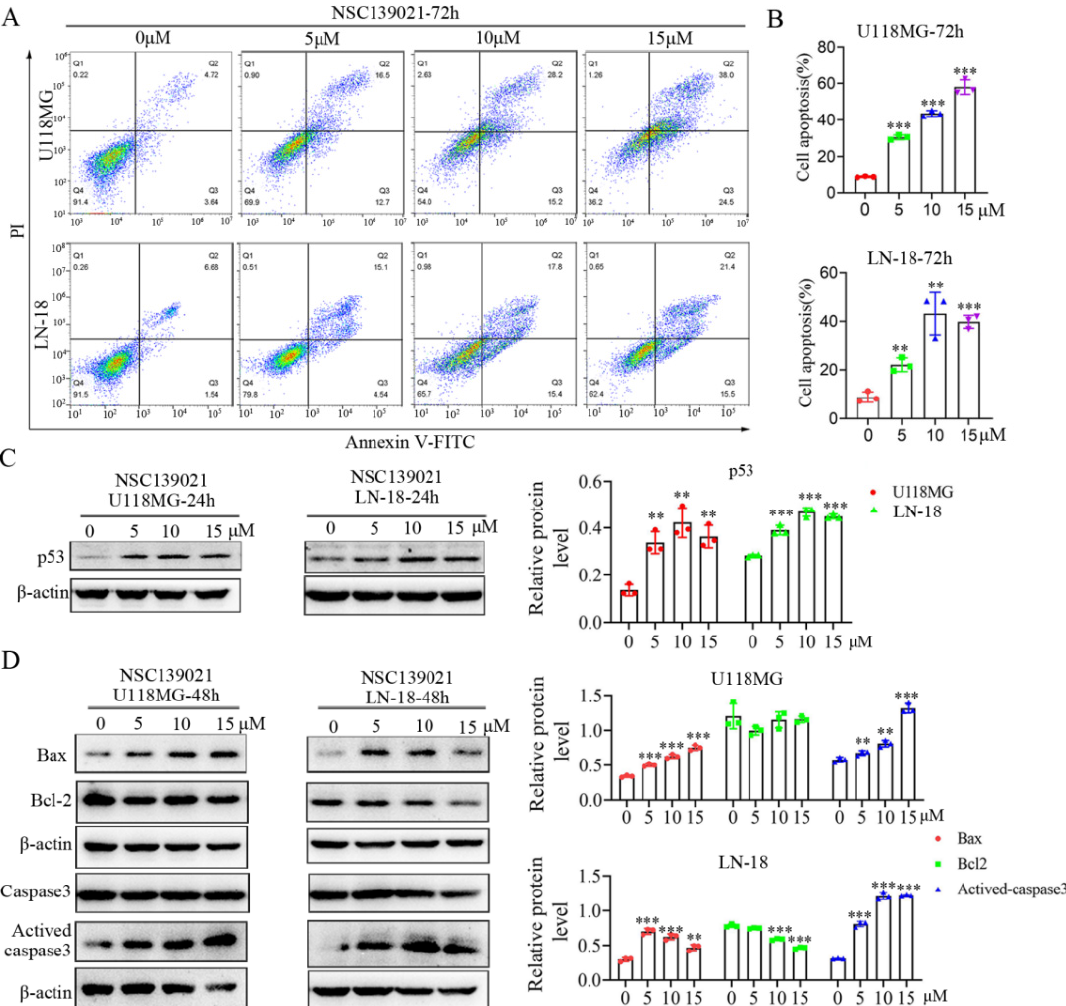
Figure 4. NSC139021-induced apoptosis of glioblastoma cells via activating the p53 signaling pathway. ( A ) Flow cytometric analysis with Annexin V and PI staining indicated that NSC139021 (5, 10, 15 µ M) treatment for 72 h increased the percentage of apoptosis rate in U118MG and LN-18 cells.